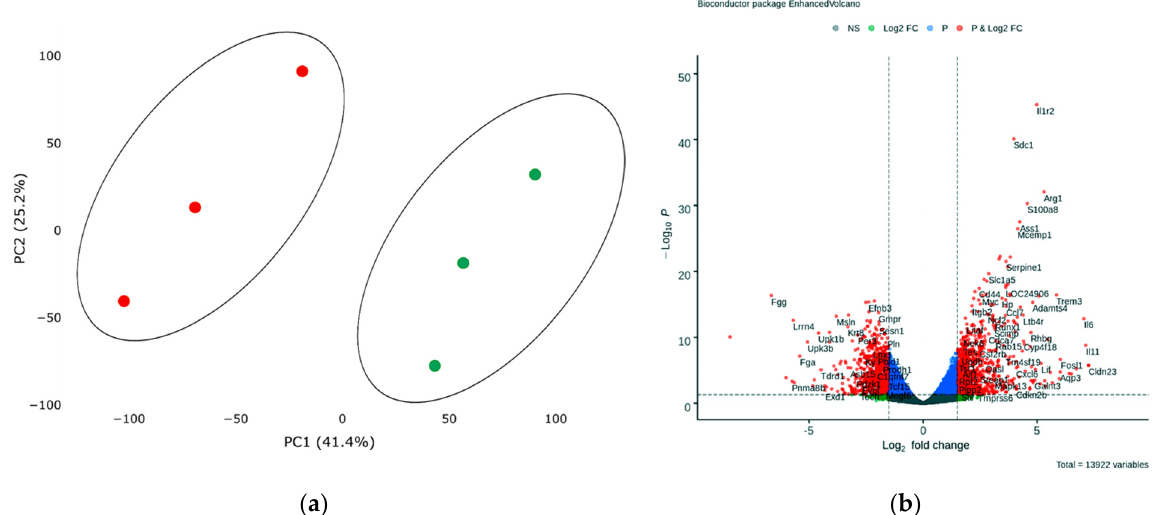
Figure 1. ( a ) Principal component analysis (PCA) displays variability in gene expression in healthy (green dots, n = 3) and postinfarction (orange dots, n = 3) myocardial tissues using the Phantasus Web Tool. Major component 1 (PC1) on the x -axis and PC2 on the y -axis accounted for 41.4% and 25.2% of the total variability in gene expression, respectively. PC1 covers a significant part (41.4%) of the experimental variability and largely reflects the difference between the two states of the heart muscle. PC2 represents experimental variability (25.2%) associated with the difference in gene profile between various biological repeats (laboratory animals). The samples are visually divided into two main groups. ( b ) Volcano plots showing differentially expressed genes (adjusted p -value < 0.05) in post-infarction samples compared to controls, performed using Bioconductor software in R. The y -axis corresponds to the mean expression value of − log10 ( p -value), and the x -axis displays the log2 (fold-change) value. The red dots represent significantly differentially expressed genes.